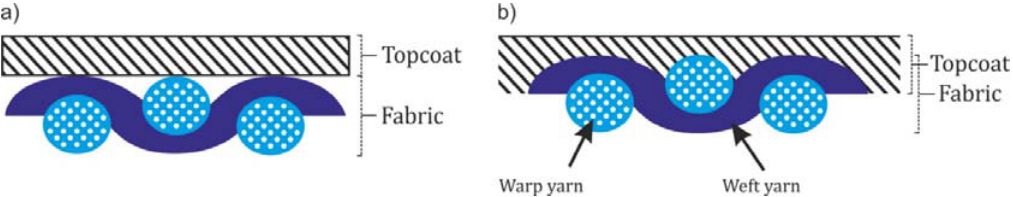
Figure 1. Two ways of applying a polymer layer to fabrics: ( a ) lamination; ( b ) coating.